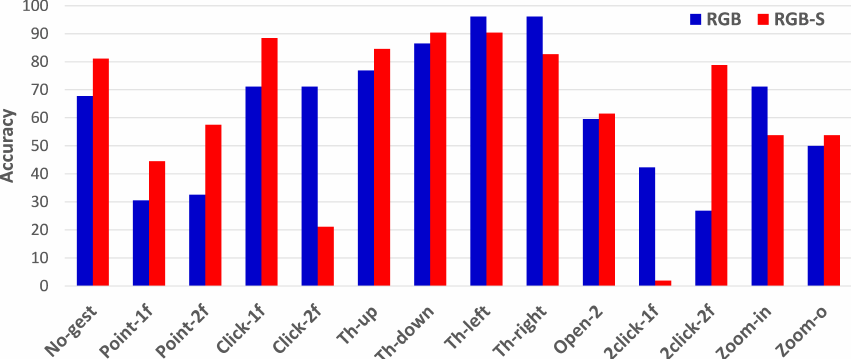
Figure 8. Per-class accuracy performance of TSM with 32 segments using RGB and RGB-S